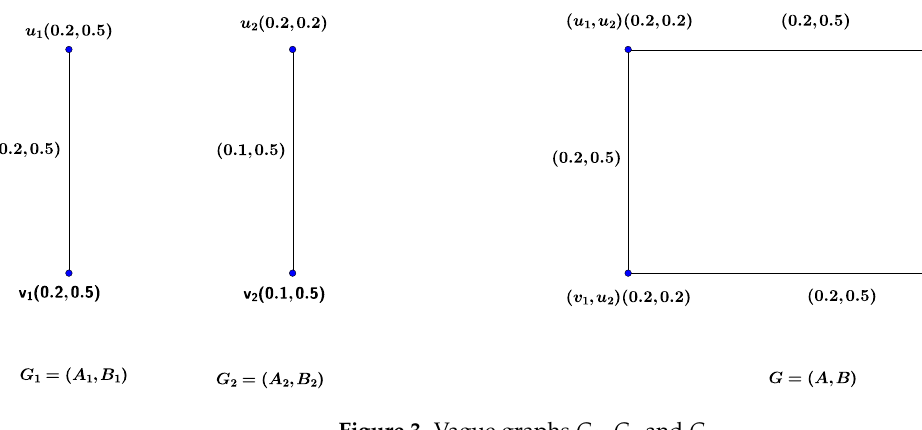
Figure 3. Vague graphs G 1 , G 2 and G .